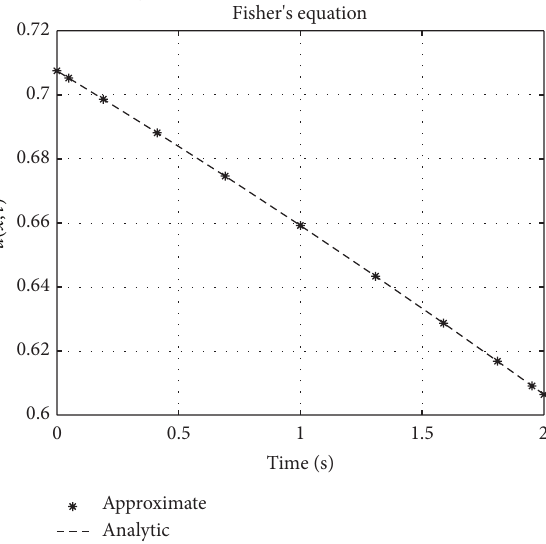
Table 12: Maximum errors 𝐸 𝑁 for the highly nonlinear modified KdV equation, with 𝑁 𝑡 = 10 . Figure 1: Fishers equation analytical solution graph.